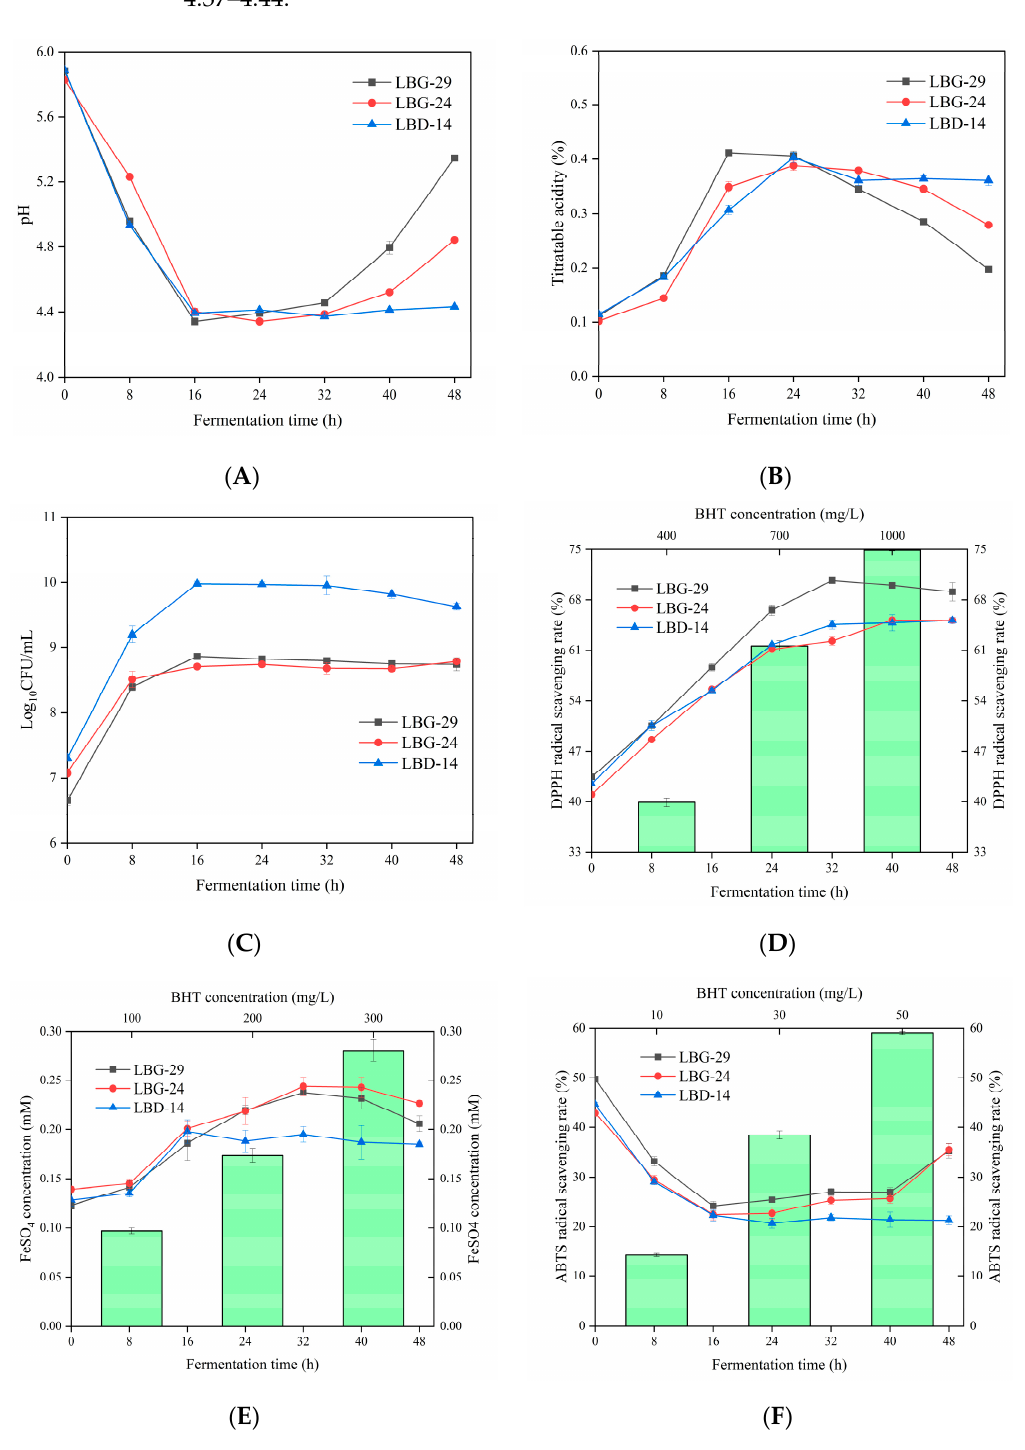
Figure 4. Fermentation time dependence of pH ( A ), titratable acidity ( B ), viability ( C ), DPPH radical scavenging ( D ), FRAP ( E ), and ABTS radical scavenging ( F ) in litchi juice fermentation. Values are means ± SD.